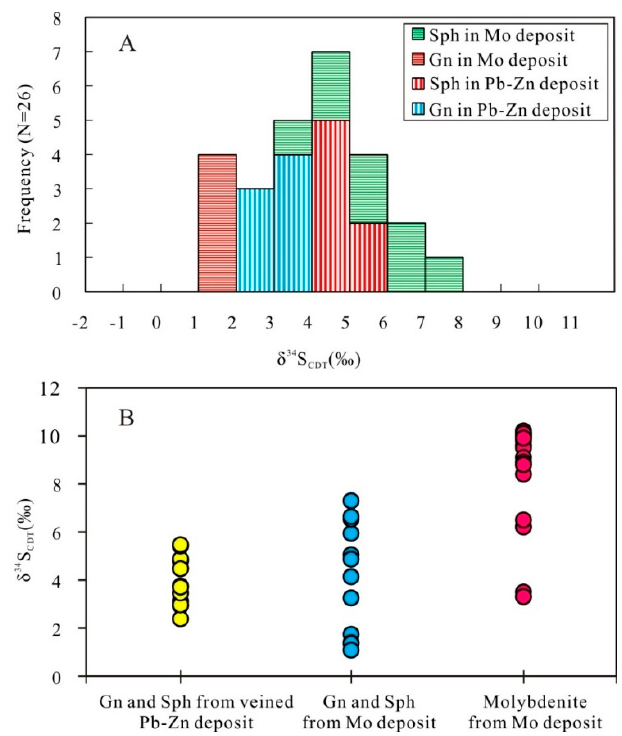
Figure 7. Sulfur isotope histogram of galena and sphalerite sampled from Mo and adjacent vein-type Pb-Zn deposits in the Diyanqinamu mine. Sulfur isotopic data of the molybdenite separates from Mo ores are quoted from [24]. Mineral abbreviations are the same as those in Figure 6. ( A ) S isotopic histogram of sulfides from the Mo and Pb-Zn deposits in the Diyanqinamu mine. ( B ) δ 34 S values of various sulfides from the Mo and Pb-Zn deposits in the Diyanqinamu mine. Table 2. Lead isotopic composition of sulfides from Mo and Pb-Zn deposits in the Diyanqinamu mine. Sample no.